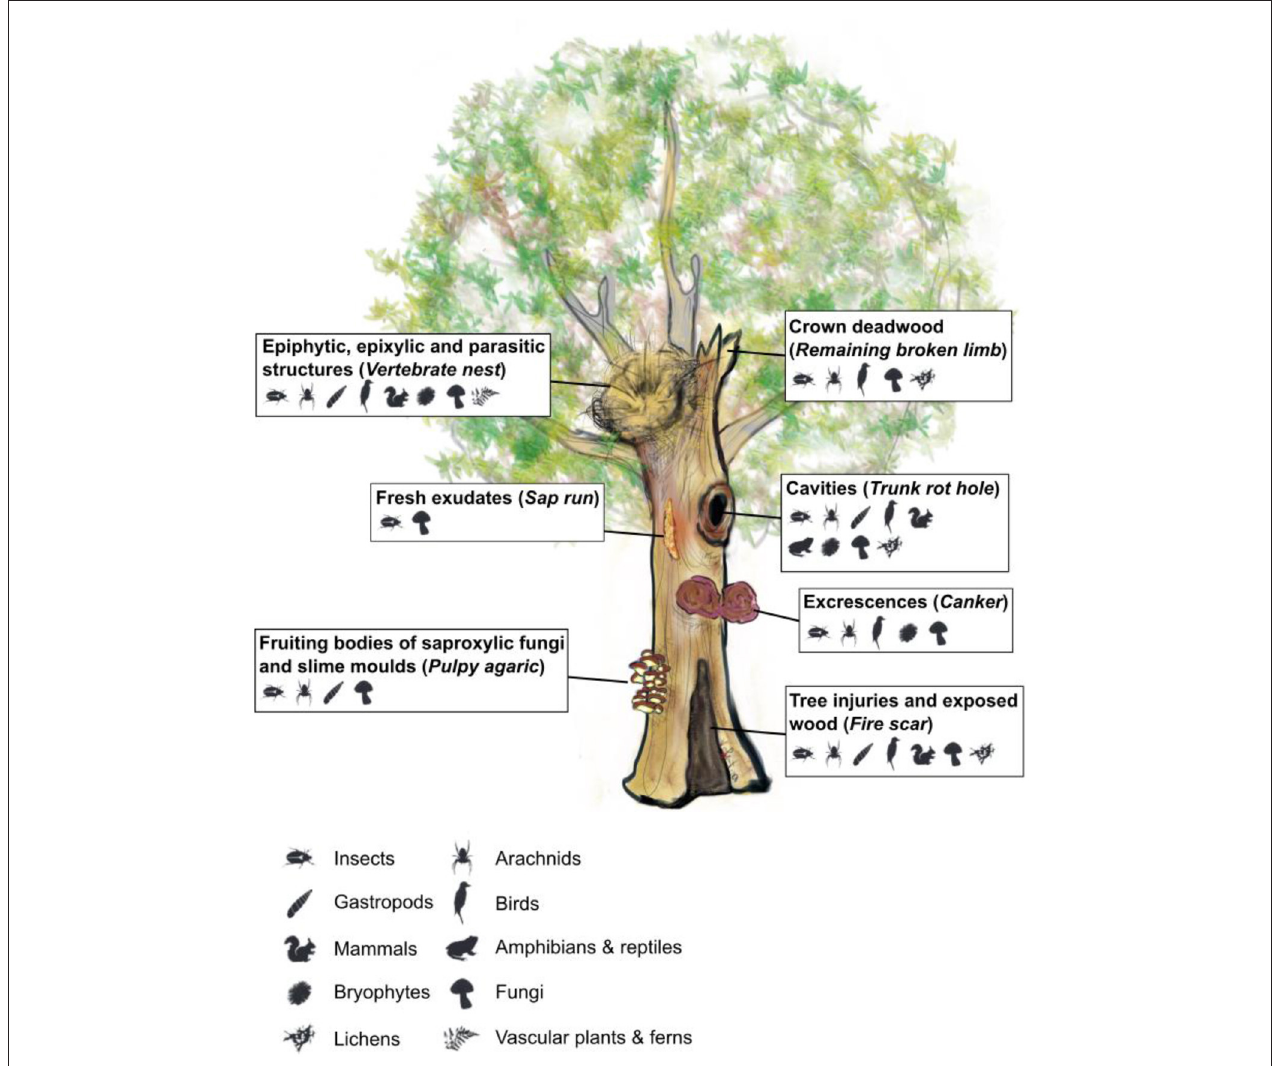
FIGURE 1 | Illustration of the seven TreM forms defined by Larrieu et al. (2018b), and link between TreM forms and taxa in European temperate and Mediterranean forests. Italic text in brackets indicates the specific TreM types represented here. Taxa pictures indicates that several species of the taxonomic group occur; these species are not necessarily strictly associated with the TreM group. Adapted from Larrieu et al. (2018b) and Bütler et al. (2020). Tree drawing by Valentina Buttò and taxa drawings by Celine